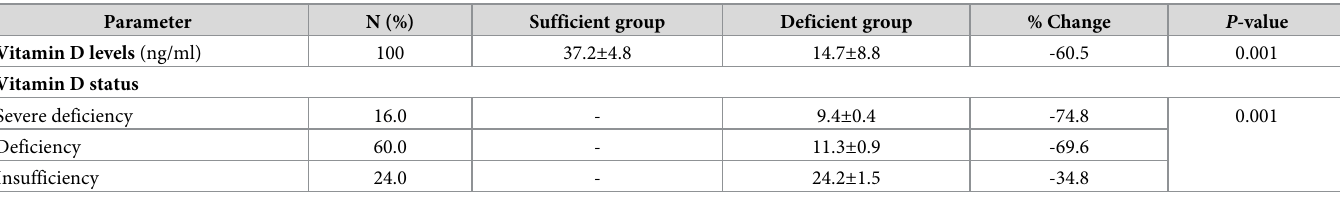
Vitamin D status based on serum vitamin D levels: severe vitamin D deficiency, serum 25OHD level < 5- � 10 ng/mL; vitamin D deficiency, serum 25OHD levels > 10-